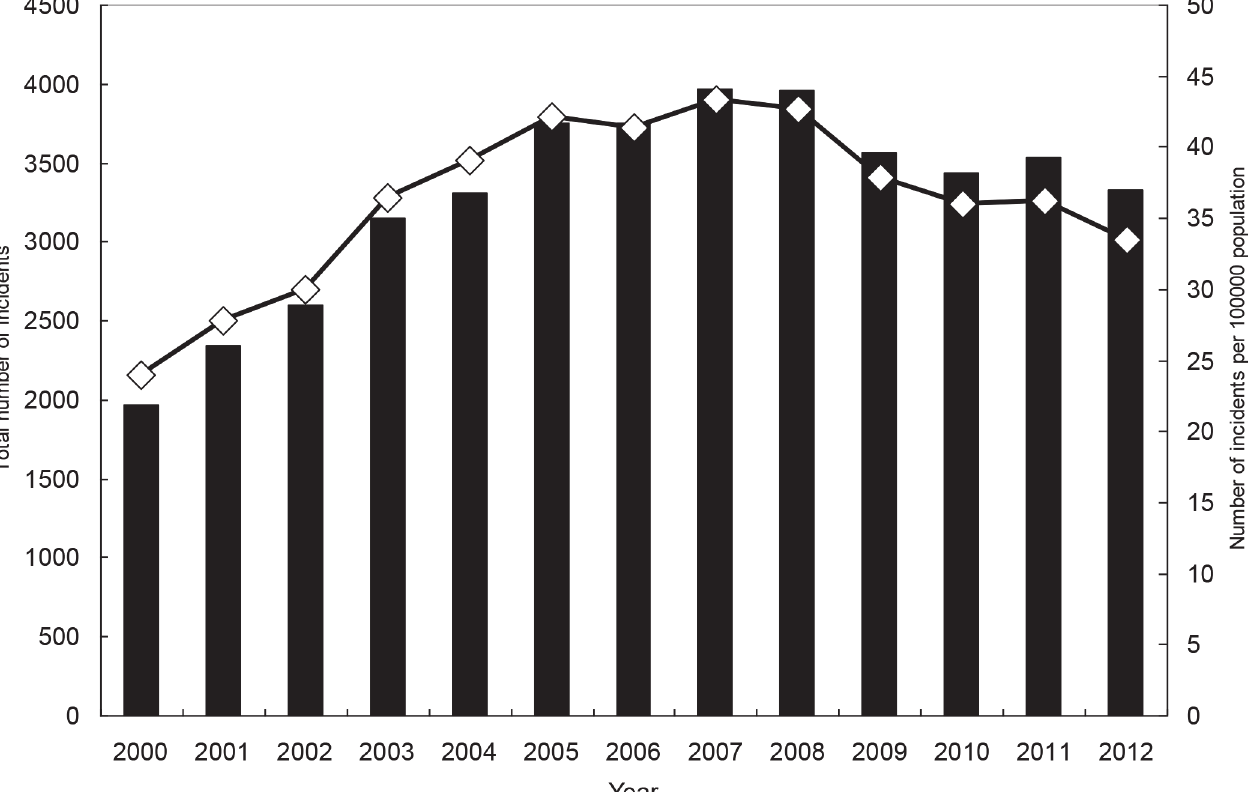
Fig 5. Total numbers of incidents with out-of-hospital cardiac arrest and incident rates, for women.